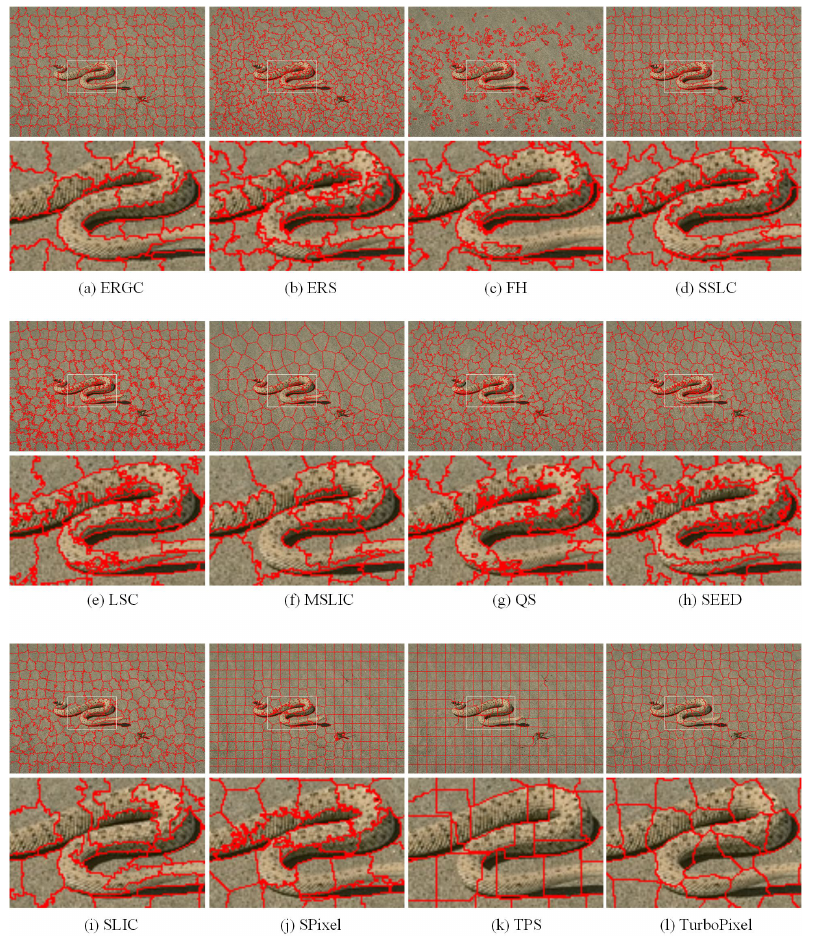
Figure 6. Superpixel segmentations from an image with low variance in color. The first, third and fifth rows are superpixels generated by various methods. The second, fourth and sixth rows zoom in on the regions of interest as defined by the white boxes to facilitate close visual